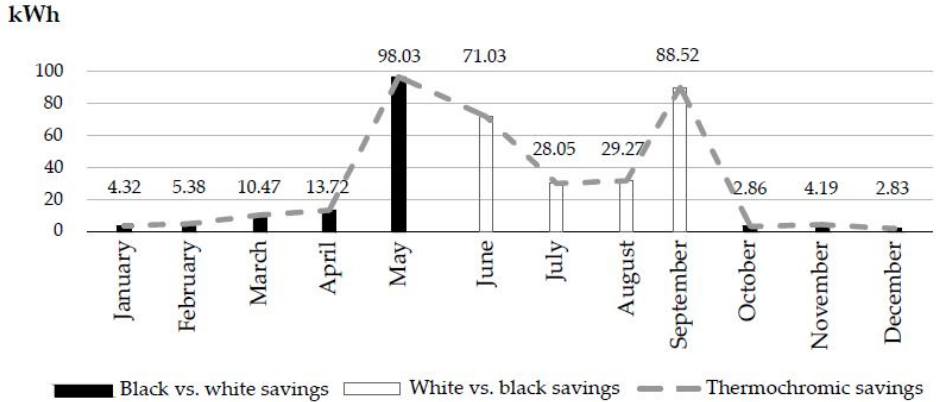
Figure 9. Monthly energy savings for NBE-79 with black, white, and thermochromic surface finishes in the Madrid CZ.